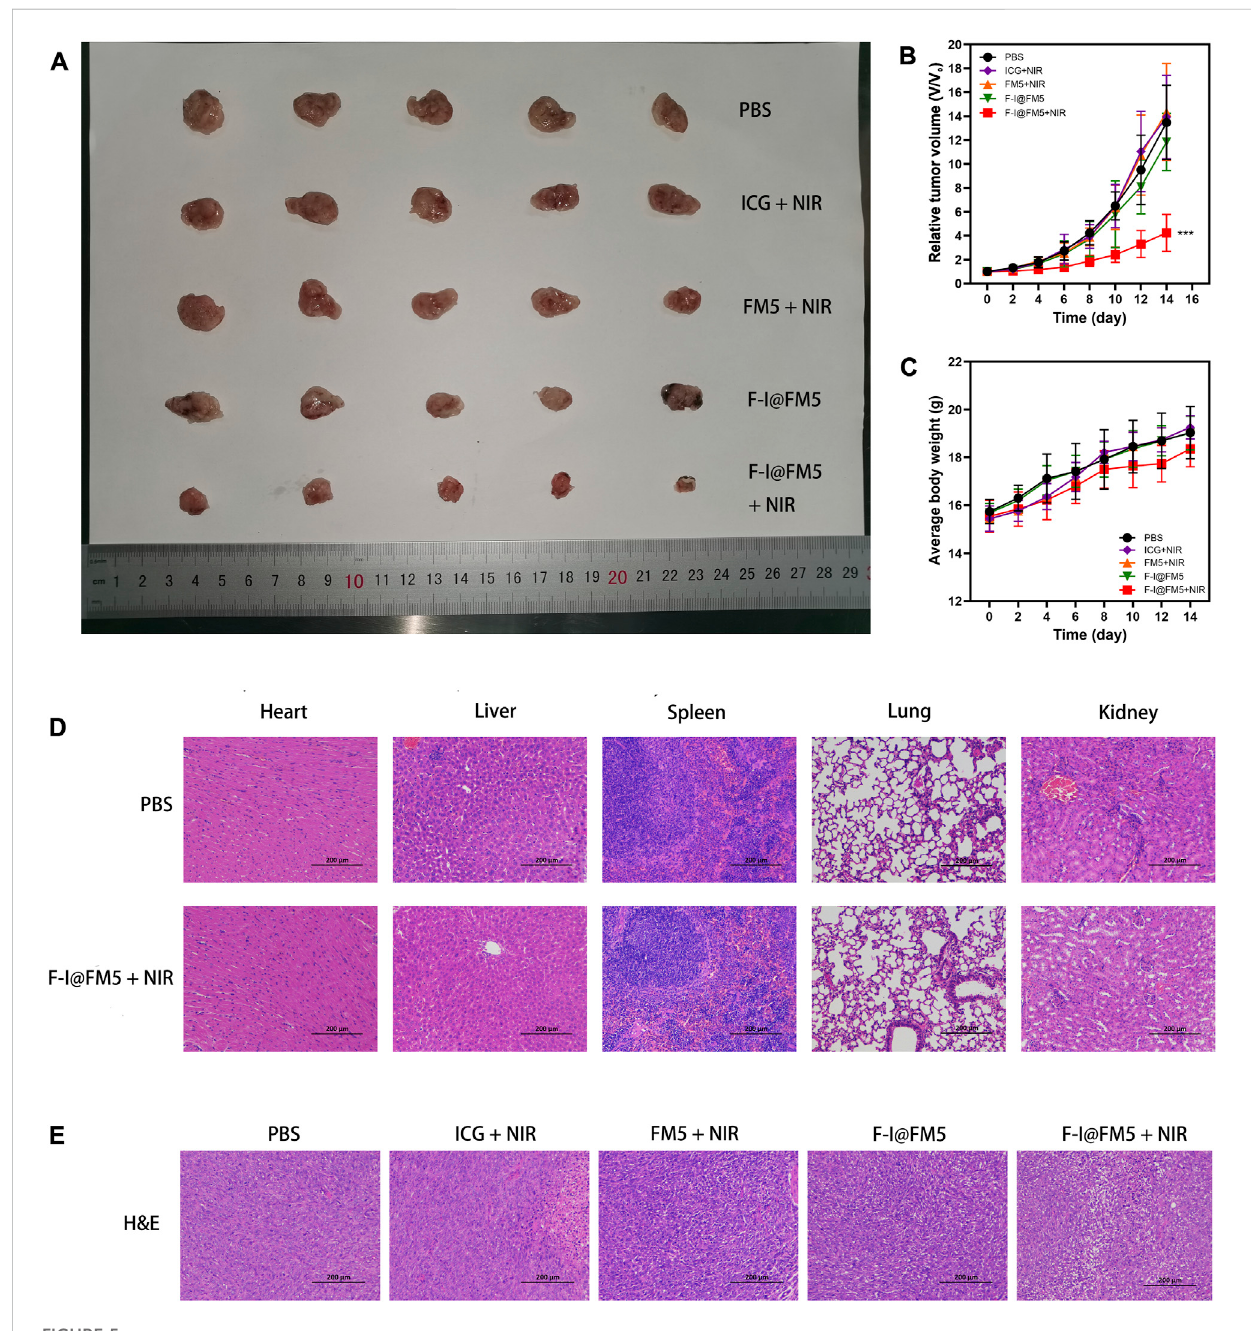
Anti-tumor activitiesof F-I@FM5 in EMT-6tumor-bearing mice. (A) Photograph of harvested tumor frommice after 14 dofdifferenttreatments. (B) Tumor growth curves of mice during the 14 days treatment. (C) Animal weight changes of different groups during the treatment period. Error bars represent mean ± SD (* p < 0.05, ** p < 0.01, *** p < 0.001. n = 5 per group). (D) Histological observation of major organs for safety determination by comparing the F-I@FM5+NIR group to the normal group. (E) Histological observation of the tumor tissues with H&E staining from different treatment groups of